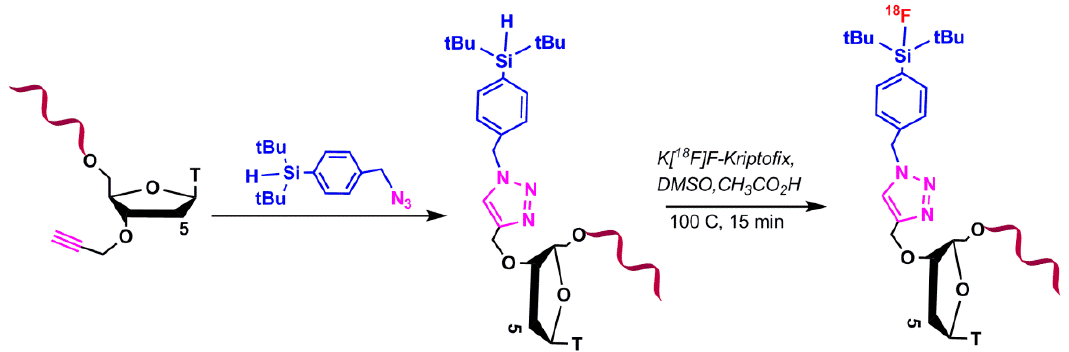
Figure 11. Conjugation of 18 F by substitution of hydrogen atom on silylated oligonucleotide.